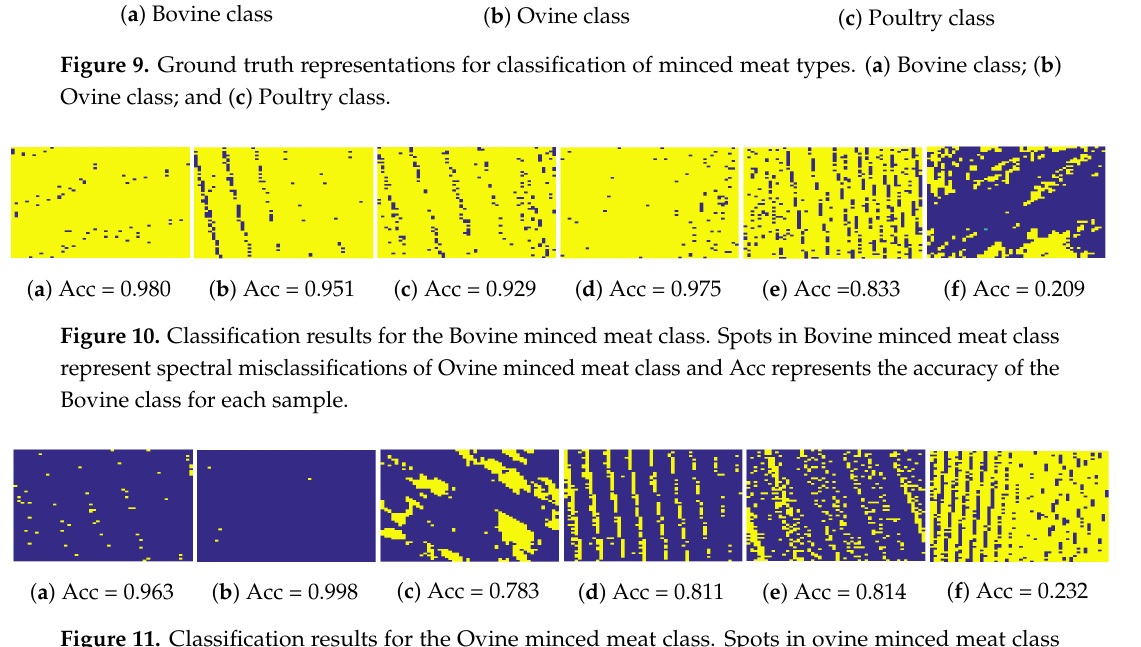
Figure 11. Classification results for the Ovine minced meat class. Spots in ovine minced meat class represent the spectral misclassifications of Bovine minced meat class and Acc represents the accuracy of the Ovine class for each sample.